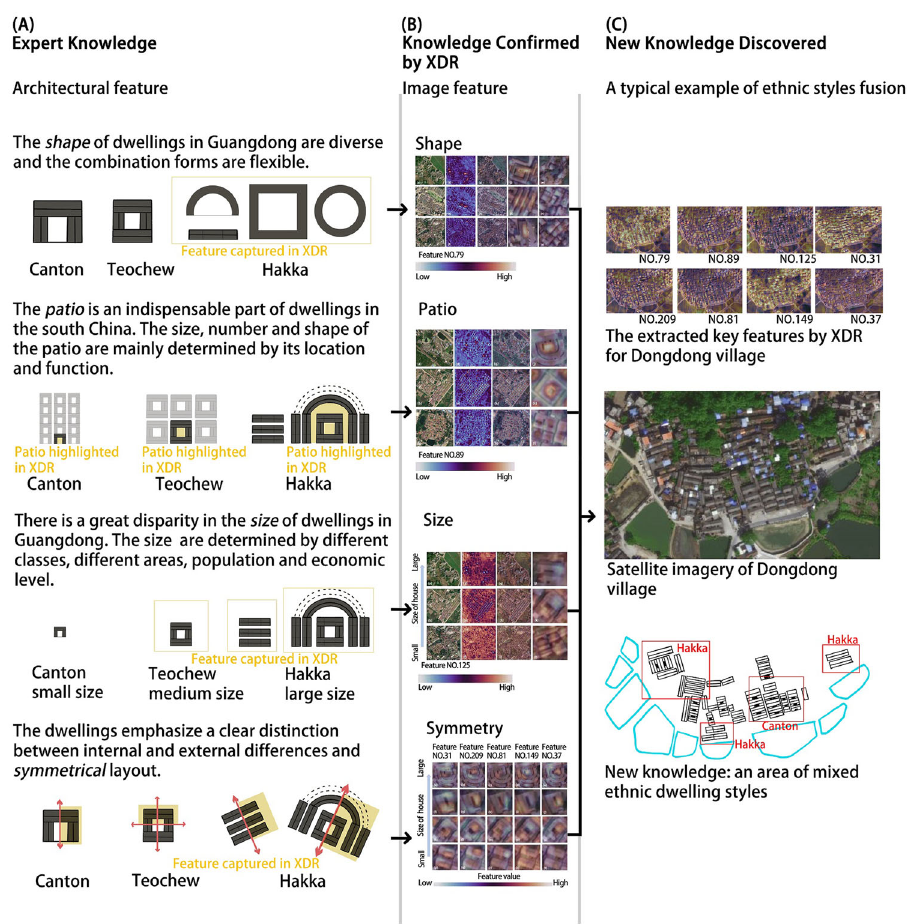
Fig. 11 How XDR con fi rms expert knowledge and helps discover new knowledge. Panel a addresses what expert knowledge is used for infusion. The expert knowledge that is con fi rmed by the XDR framework is highlighted in yellow. Panel b addresses which expert knowledge is con fi rmed by the XDR. The con fi rmed architectural feature is highlighted in different feature maps. Panel c addresses how the XDR helps discover new knowledge by presenting an example of the discovery of a village of mixed ethnic